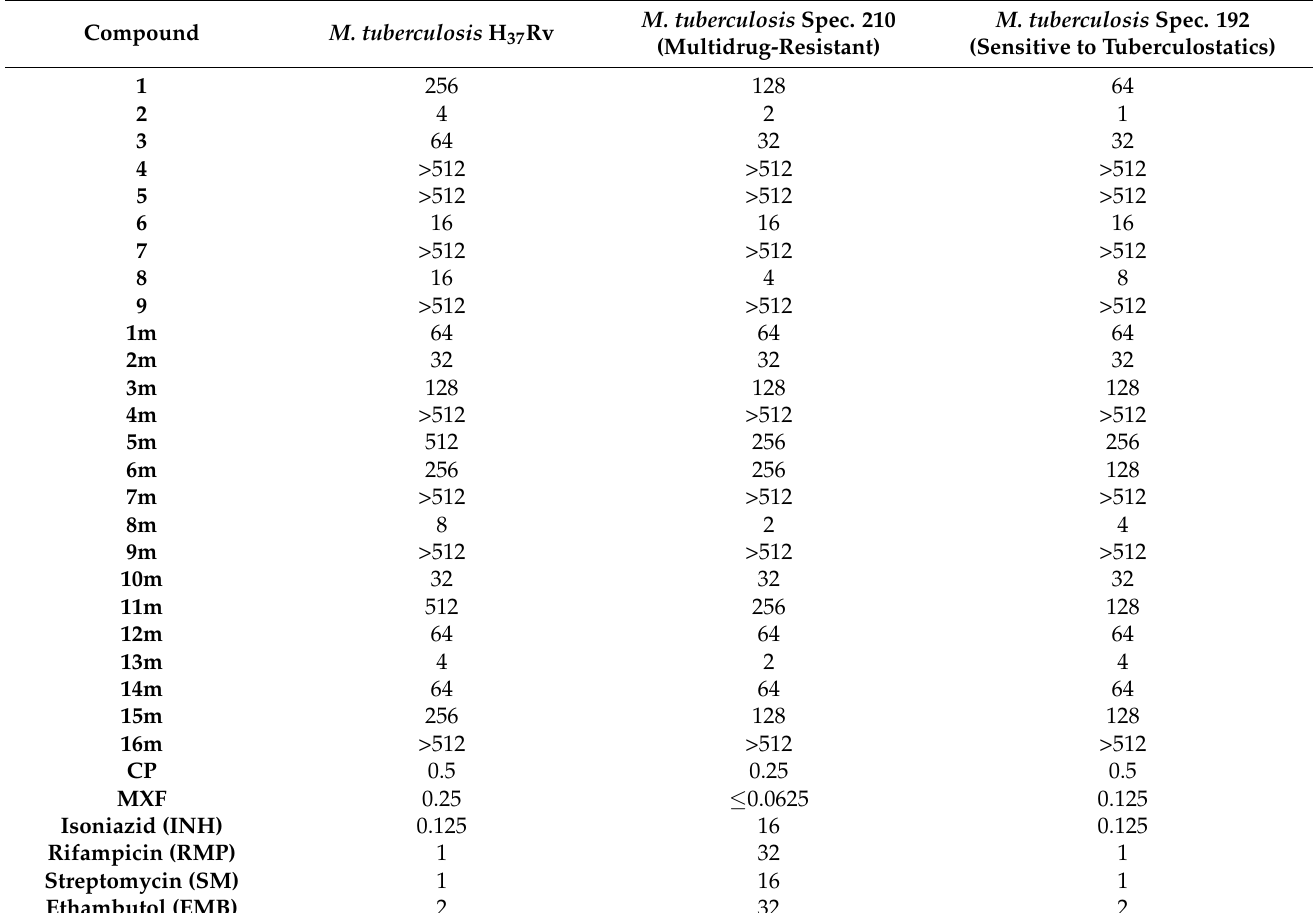
Table 4. Activity of synthesized compounds against selected Mycobacterium tuberculosis strains after 2 weeks of treatment–minimal inhibitory concentrations (MIC, µ